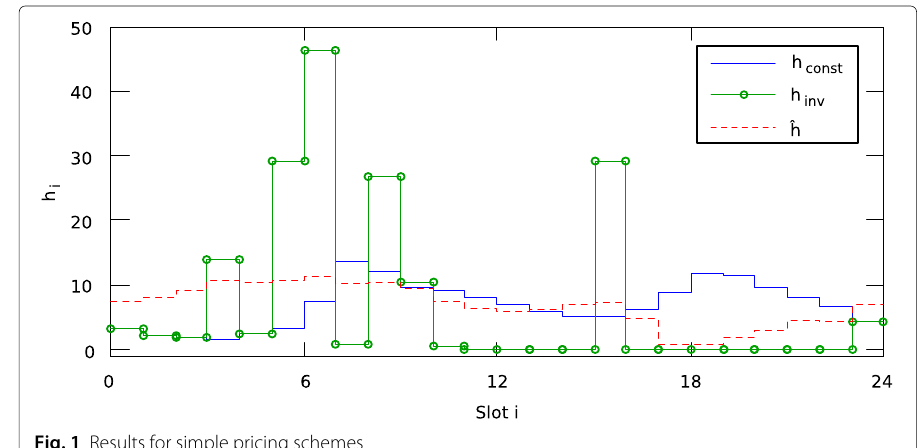
Fig. 1 Results for simple pricing